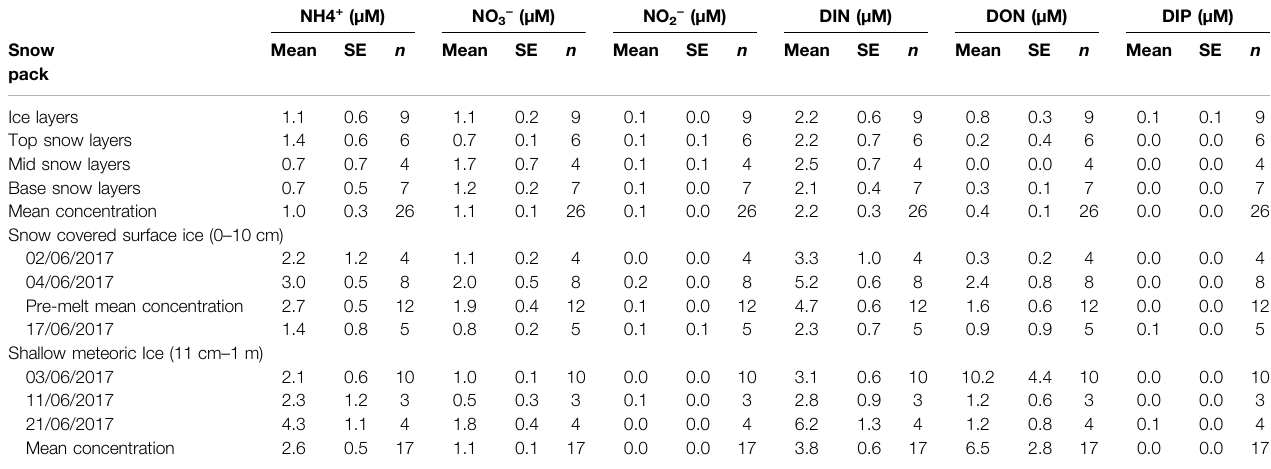
TABLE 1| Mean ±SEconcentration ofNspecies ammonium (NH 4+ ) nitrate(NO 3 − ),nitrite (NO 2 − )and dissolved organic nitrogen (DON)in thesnowpack, underlying surface ice and shallow meteoric ice (to a depth of ~1 m) near S6 on the K-Transect, SW Greenland. Dissolved inorganic phosphorus (DIP) data is also presented, although almost values are below quanti fi cation. n for snow pack samples denotes the number of layers sampled, n for snow covered surface ice samples denotes the number of samples taken on that date, and n for ice core samples denotes the number of ice layers, other than the surface 10 cm, which were sampled. Mean composition for snow covered surface ice samples only includes pre-melt sampling dates (02/06/17 and